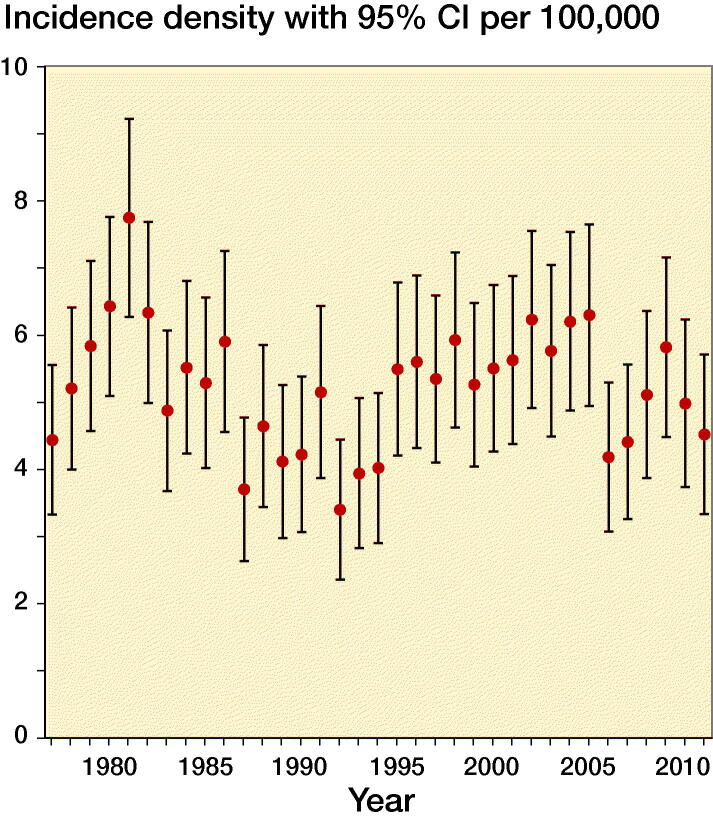
Incidence density of SCFE diagnoses per 100,000 children aged 5 to 16 years in Sweden from 1977 to 2011.